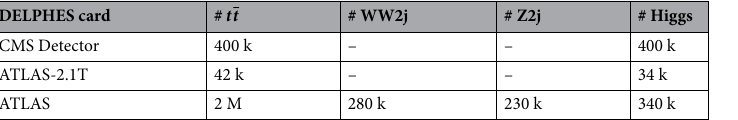
Table 2. Overview of the number of instances in the generated data sets after applying the quality cut of 2 leptons and > 2 jets. ATLAS-2.1T indicates that the magnetic field in the ATLAS DELPHES detector card was changed from 2T to